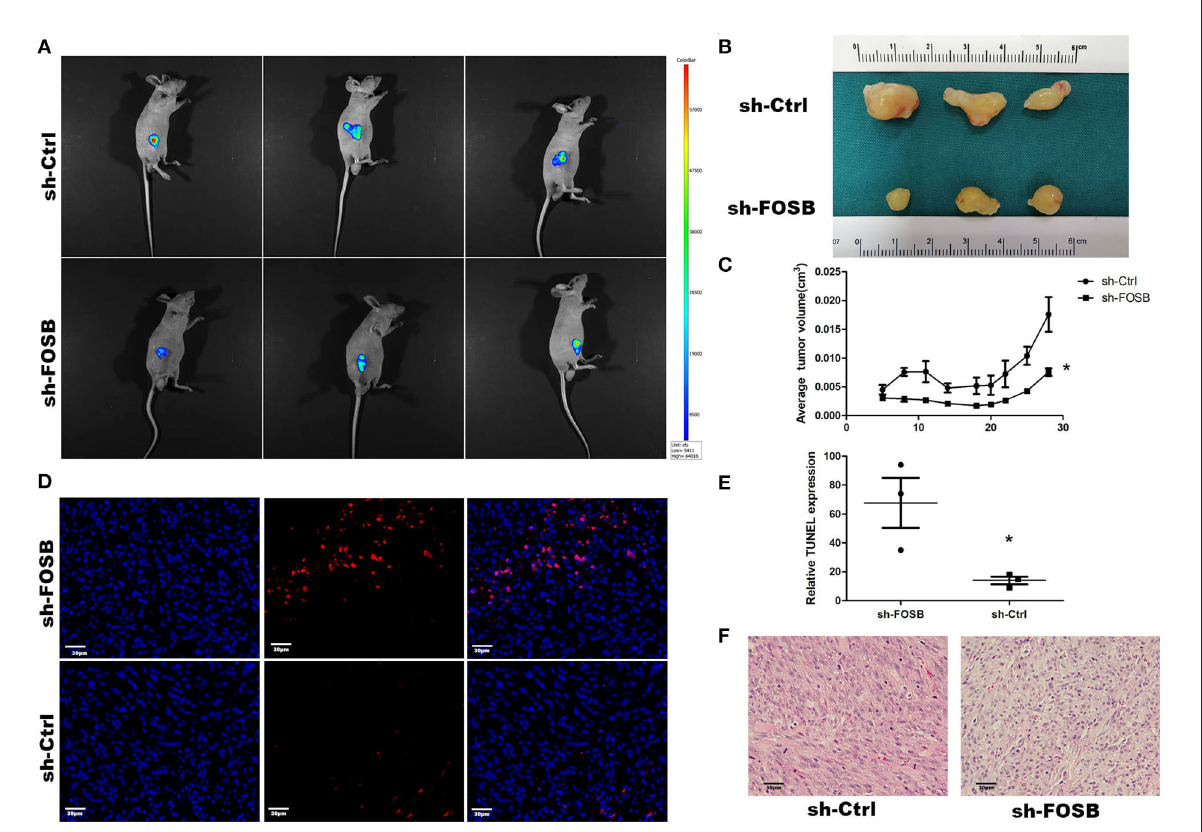
FIGURE4 In vivo effect of FOSB expression on promoting the growth of mouse GBM cell xenografts. (A) Imaging of mice. The nude mice of the sh-FOSB group and sh-Ctrl group on the 28th day of subcutaneous implantation were photographed through the Small Animal in-vivo Image system. The picture shows the subcutaneous tumor with GFP fluorescence. (B) After 28 days of GBM cell implantation, the tumor xenografts were removed from the mice and compared. (C) Tumor volume. The subcutaneous tumor-bearing volume of mice in the control and experimental groups was measured on days 5, 8, 11, 14, 18, 20, 22, 25, and 28, respectively ( n = 3, * P < 0.05 vs. sh-Ctrl group). (D) TUNEL staining. The resected tumor xenografts were subjected to TUNEL staining. (E) It was the counting result of positive cells in (D) , * P < 0.05 vs. sh-Ctrl group. (F) Hematoxylin-eosin staining was performed in the experimental group and the experimental group after subcutaneous